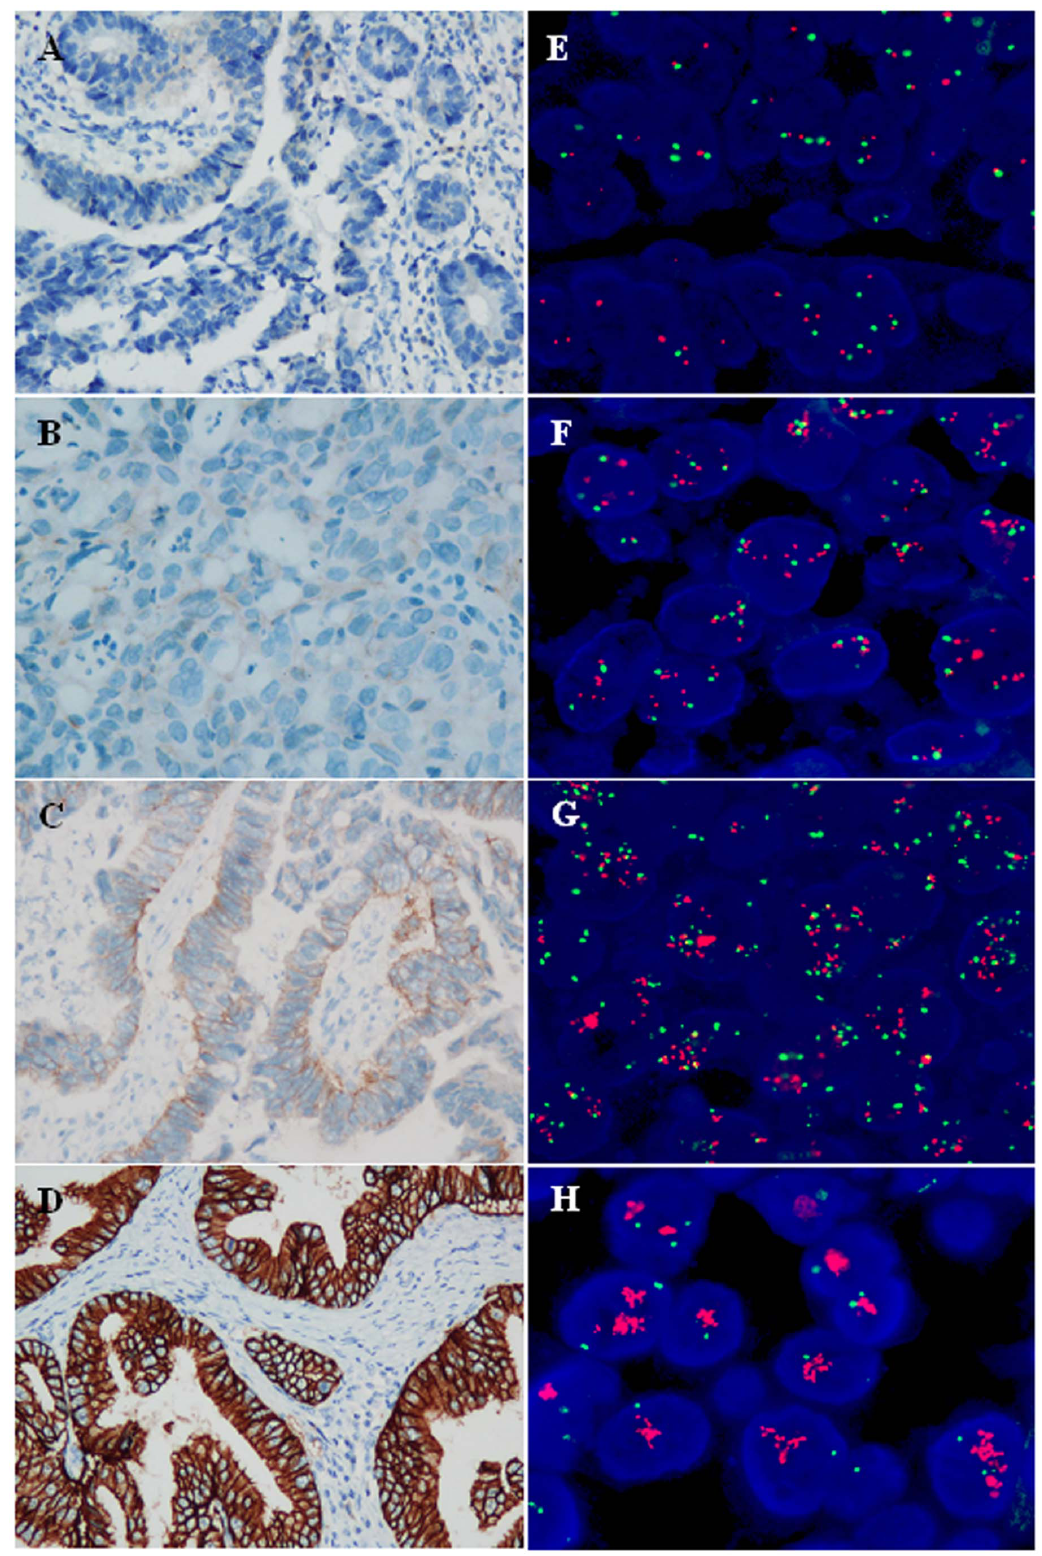
Figure 1. HER 2 protein expression and gene amplification in gastric cancer tissue. A–D show HER 2 protein expression detected by IHC (original magnification 6 200). A, HER 2 IHC score of 0; B, 1 + ; C, 2 + ; D, 3 + . E–H show HER 2 gene amplification evaluated by FISH (original magnification 6 1000). E, no amplification; F, low level of amplification; G, moderate level of amplification; H, high level of amplification (HER 2 signal cluster).